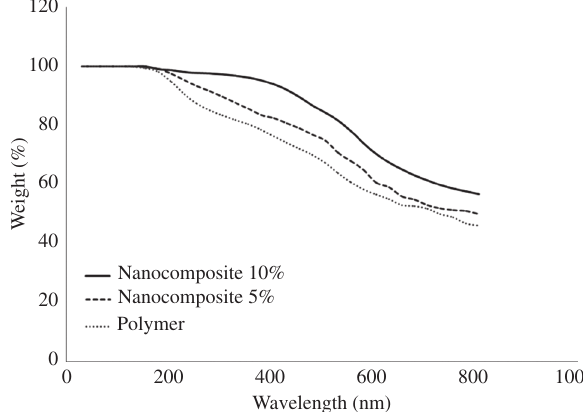
Figure 6 TGA curves of neat PAI 4 and PAI-nanocomposite films 4a and